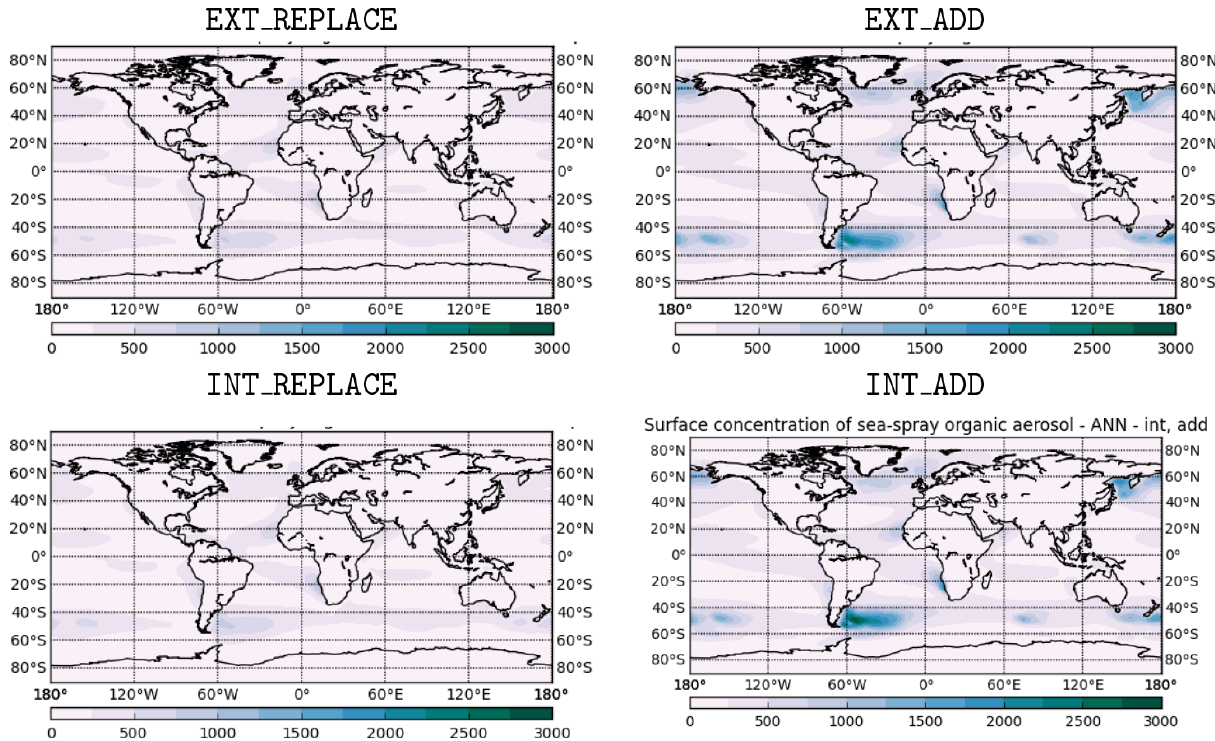
Figure 7. Simulated annual mean mass concentration (ng m − 3 ) of MOA (near-surface concentrations) for four sensitivity cases described in Table